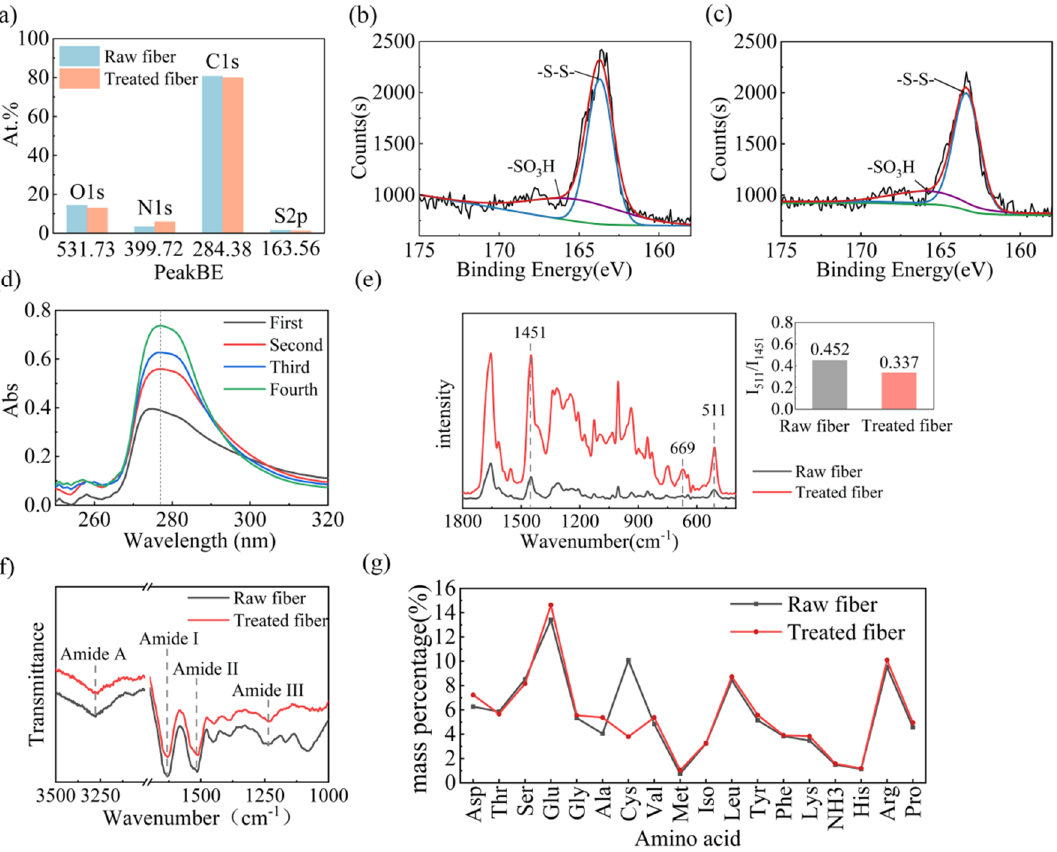
Figure 5. ( a ) The content changes of main elements on the surface of different fiber samples. Binding energy spectra of sulfur in raw wool ( b ) and treated fibers ( c ). ( d ) UV absorption spectra of the residual solution in each soaking tank after finishing wool fibers with L/PTSS. ( e ) Raman spectra, ( f ) Fourier infrared spectra, and ( g ) amino acid content of raw wool and treated fibers.